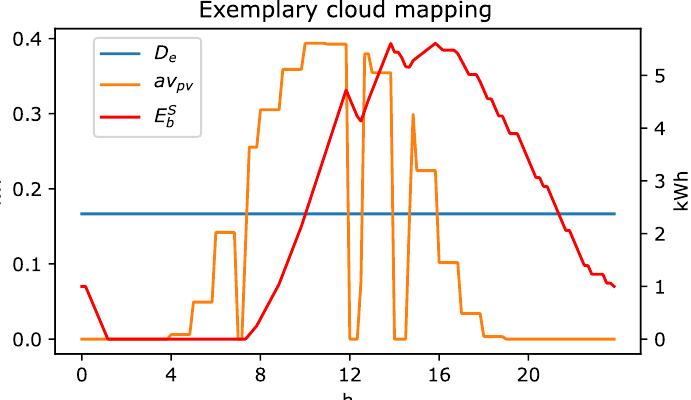
Figure 3. Exemplary solar radiation time series (yellow line) created by the mapping for randomly sized and randomly distributed clouds. The resulting cost-optimal battery storage levels (red line), which provide for the constant electricity demand (blue line), are